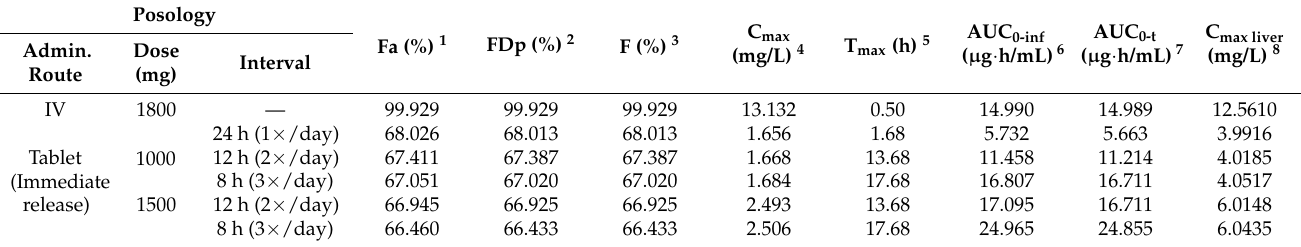
Table 2. Predicted pharmacokinetic properties of gemcitabine determined with GastroPlus™ for different treatment conditions. Posology